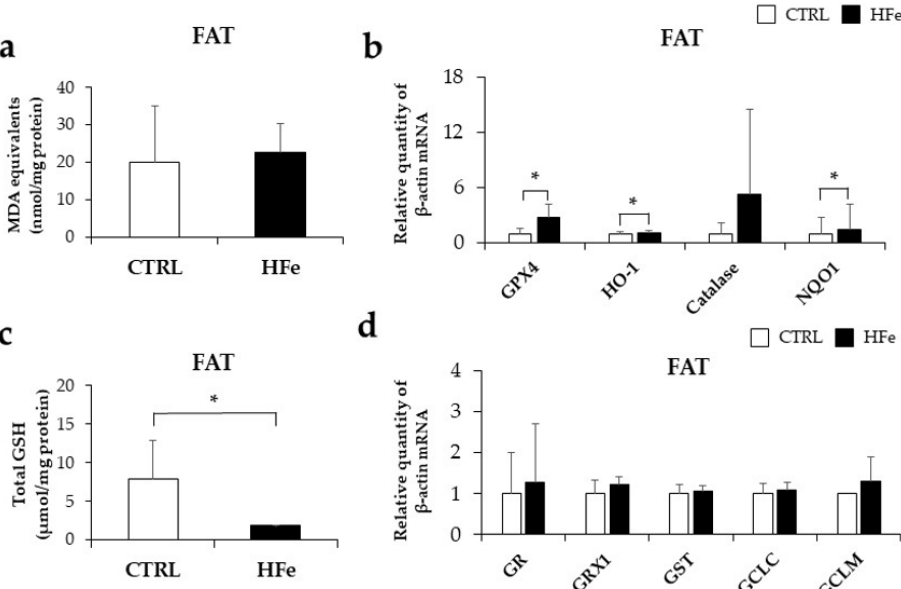
Figure 6. The HFe enhanced Nrf2-related antioxidant expression. ( a ) Estimation of MDA in mesen- teric fat of each group (CTRL, HFe). ( b ) mRNA expression related to antioxidant enzymes. ( c ) Con- tents of tGSH and ( d ) RT-PCR analysis were performed to detect mRNA expression of GSH-Trx and production system in mice. All data are expressed as the mean ± S.E. Student’s t test was used to test differences between means. * p < 0.05. GPX4, glutathione peroxidase 4; HO-1, heme oxygenase-1; NQO1, quinone oxidoreductase 1; GR, glutathione disulfide reductase; GRX1, glutaredoxin 1; GST, glutathione S-transferase; GCLC, glutamate cysteine ligase catalytic; GCLM, glutamate cysteine ligase